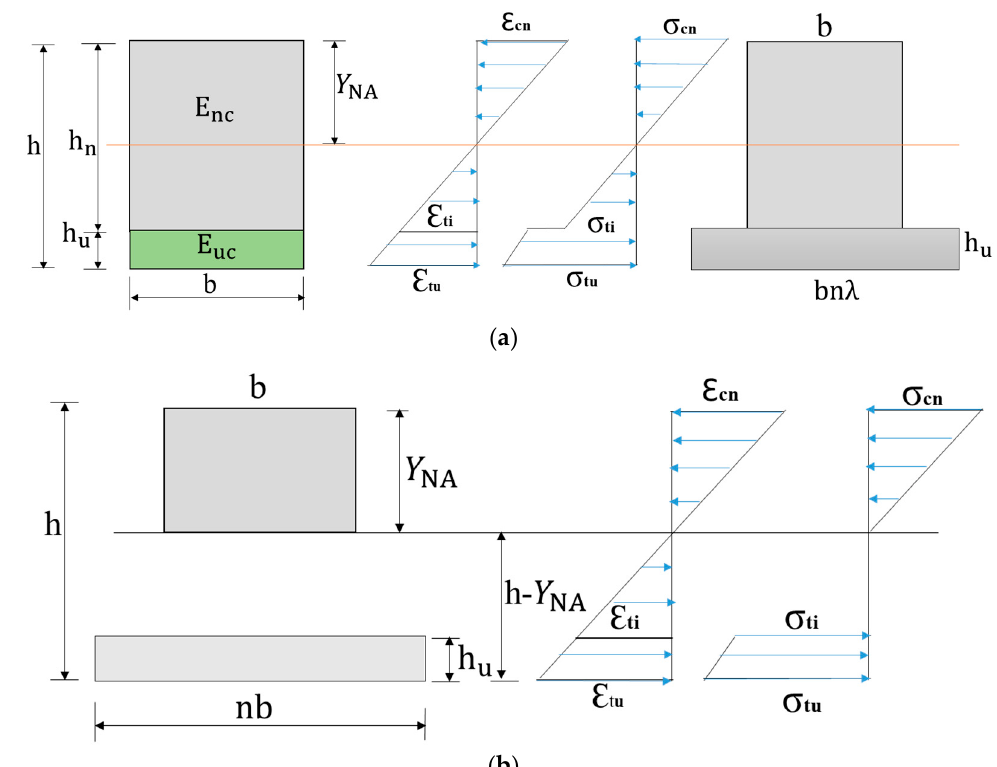
Figure 12. Moment of inertia and stresses in hybrid beam: ( a ) Uncracked section ( λ = 1) and partially cracked UHPC layer ( b ) cracked NC layer.